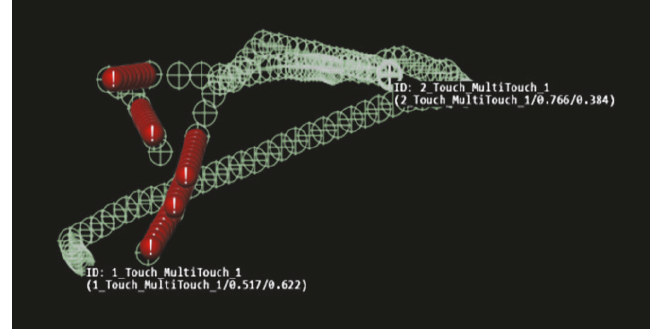
Figure 12: The computer screenshot of hands gesture tracking based on Cam-shift